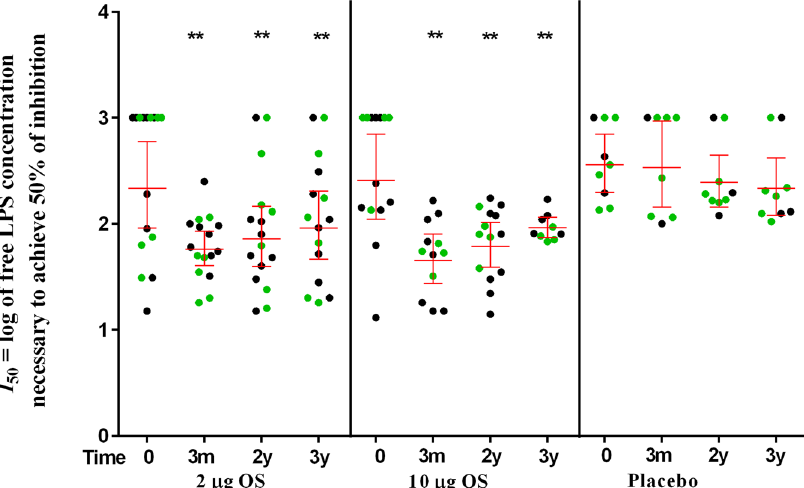
Fig. 3 Longevity of Mean Avidity I 50 (95% CIs) of IgG serum antibodies to SF2a LPS in vaccinees receiving 2 or 10 µg OS doses of non- adjuvanted and adjuvanted SF2a-TT15 and in placebo recipients. Circles represent individual I 50 index, green circles represent volunteers receiving the adjuvanted vaccine or placebo. Bars represent Mean I 50 and the 95% Con fi dence Intervals (CIs) on day 0 (baseline), at 3 months, 2, and 3 years post-vaccination. ** p -value < 0.01 (vs. day